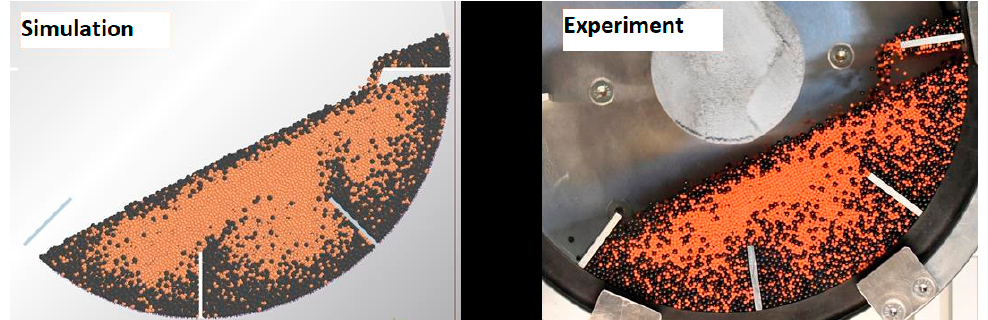
Figure 3. Simulated and experimental images of the front panel of the rotary drum showing the distribution of the beads in the first layer of the bi-size bed after 2 min (6 revolutions) of mixing. The drum is filled at ¼ of its volume and equipped with 8 baffles of 4 cm length.